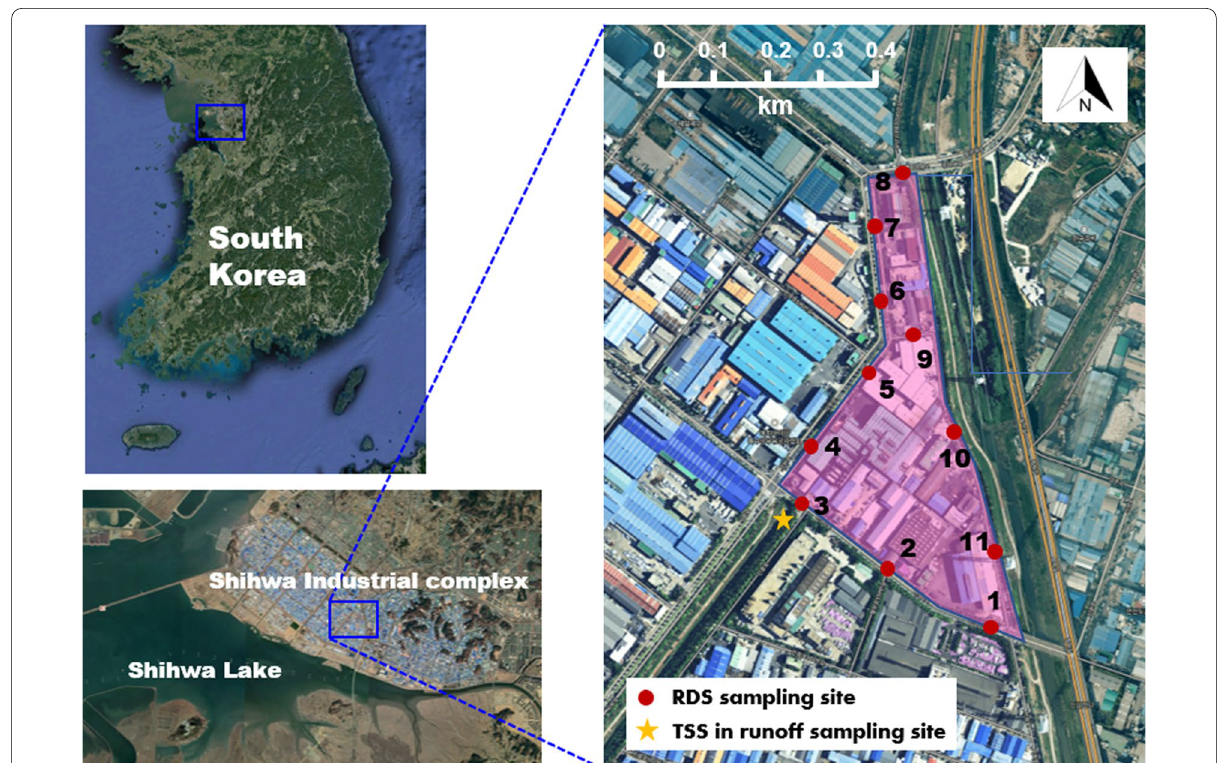
Fig. 1 Study area and sampling sites of RDS and TSS in rainfall runoff at industrial complex of Korea (The purple area represents the drainage area for runoff, base map from Google